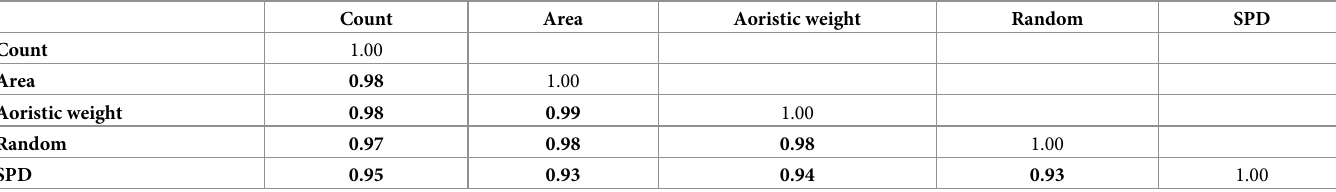
Table 6. Pearson correlation coefficient r-value matrix between the archaeo-demographic proxies (only urban sites) from 6,000 to 4,000 cal